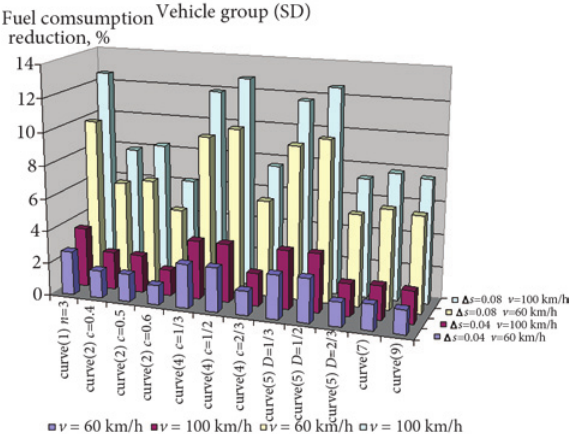
Fig. 8. Fuel consumption reduction in variant B, %, in vehicle group (SD)